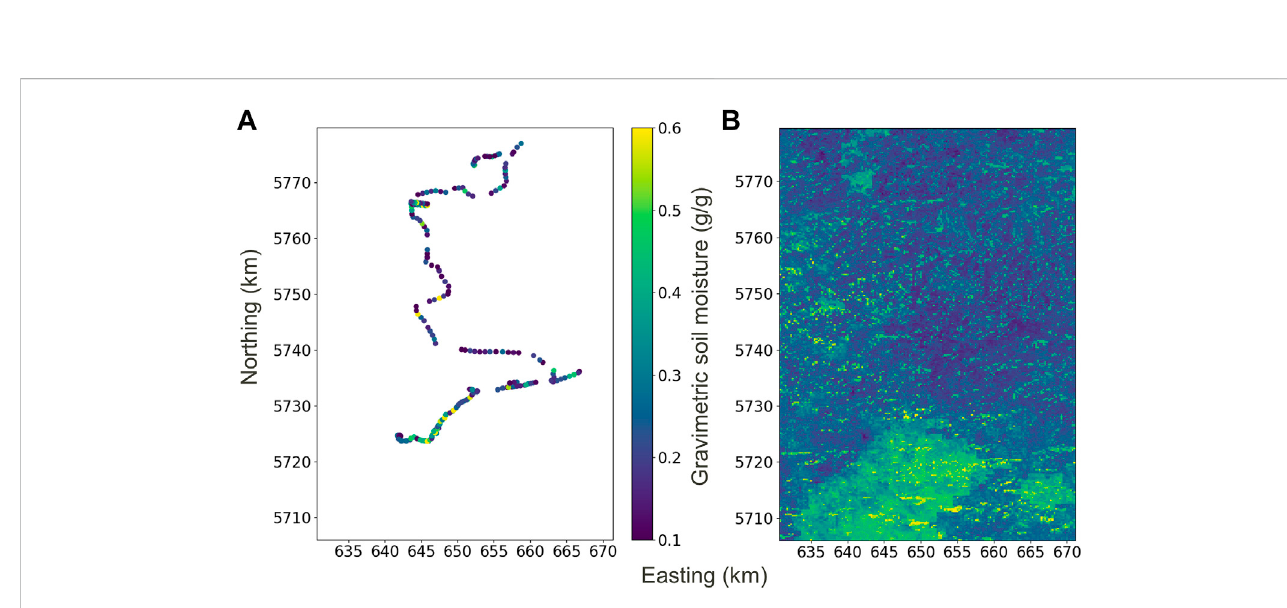
FIGURE 7 Soil moisture values at measurement locations (A) , and soil moisture map from random forest prediction of the area of interest (B)